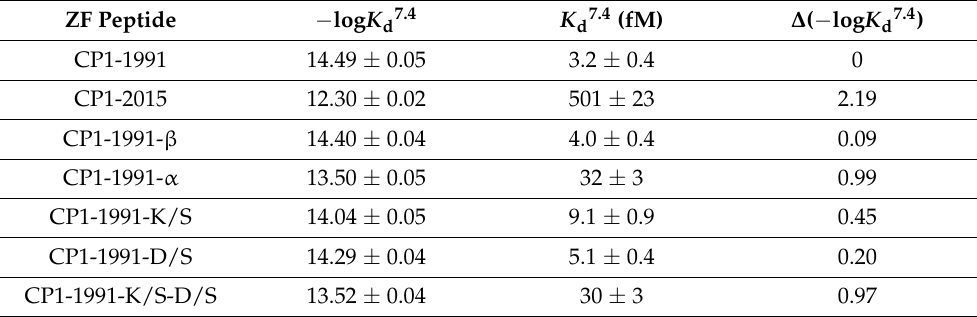
Table 1. Dissociation constant values of Zn(II) complexes with ZF peptides were determined spec- tropolarimetrically in the competition with chelators in 20 mM Tris buffer pH 7.4 (0.1 M NaCl) [14]. ∆ p K d values are differences of -log K d of CP1-1991 and particular